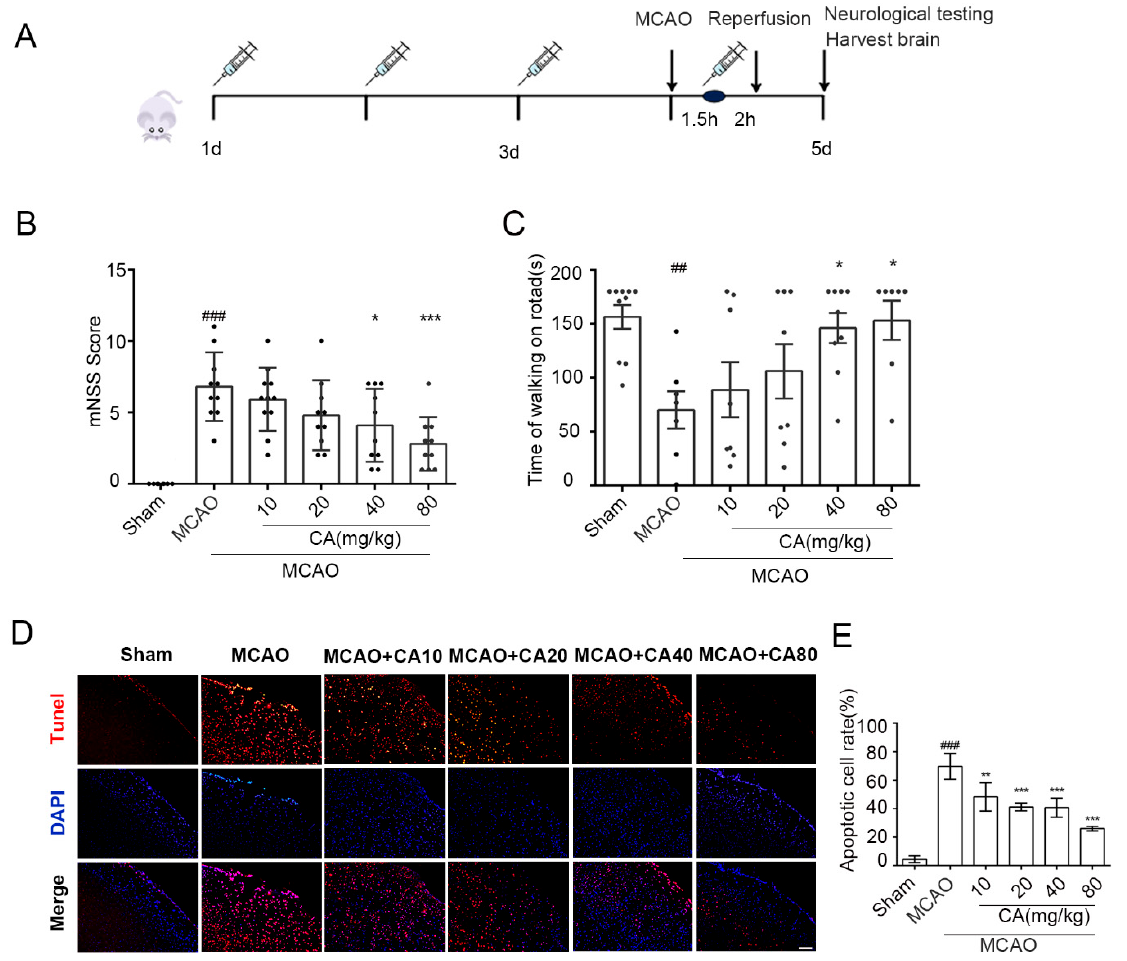
Figure 4. CA decreased cerebral damage and apoptosis following ischemia-reperfusion in vivo. ( A ) The timeline of CA administration in the OGD/R model. ( B , C ) Mouse behavioral performance in the mNSS score test and rotarod test with different treatments. ( D , E ) Effect of CA on apoptosis on the affected side of mice (TUNEL staining). Three animals were randomly selected from each group, and five fields of view were randomly selected from each section. ## p < 0.01, and ### p < 0.001 compared with the sham group. * p < 0.05, ** p < 0.01, and *** p < 0.001 versus MCAO group.